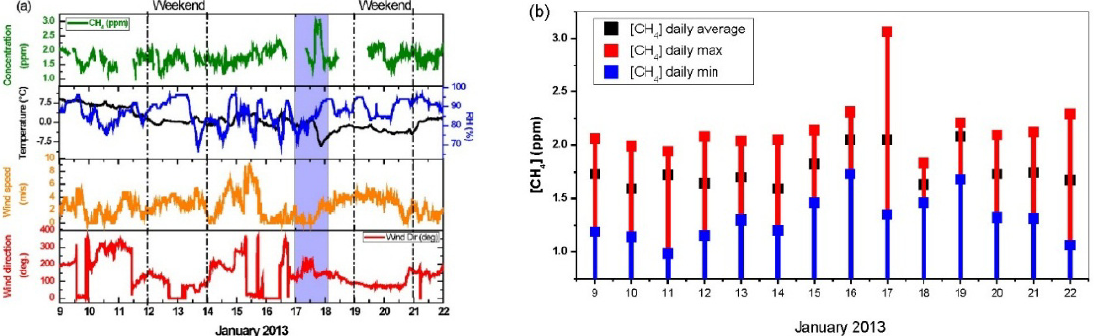
Figure 8. ( a ) Time-series methane concentrations variation sampled at 15-min intervals; ( b ) CH 4 daily average concentration (black dots), daily observed maximum (red) and minimum (blue) concentrations.